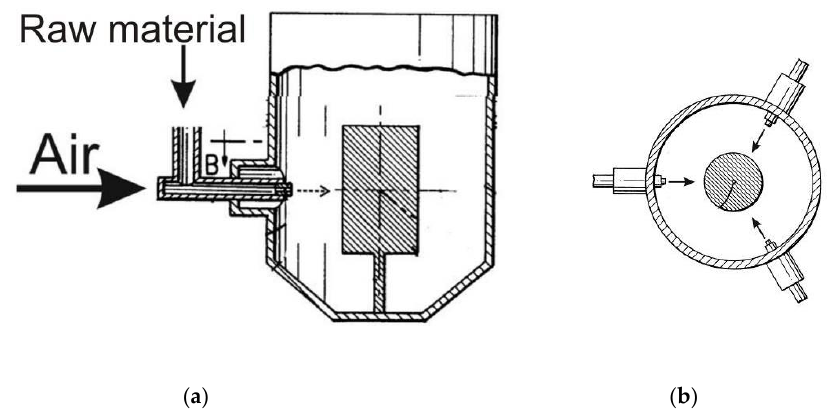
Figure 13. Schematic of a jet mill: ( a ) side view; ( b ) top view. Modified from Smith LS, Mastalski HT. A fluidized bed jet mill, EP Patent 0488637 A2, 1991.